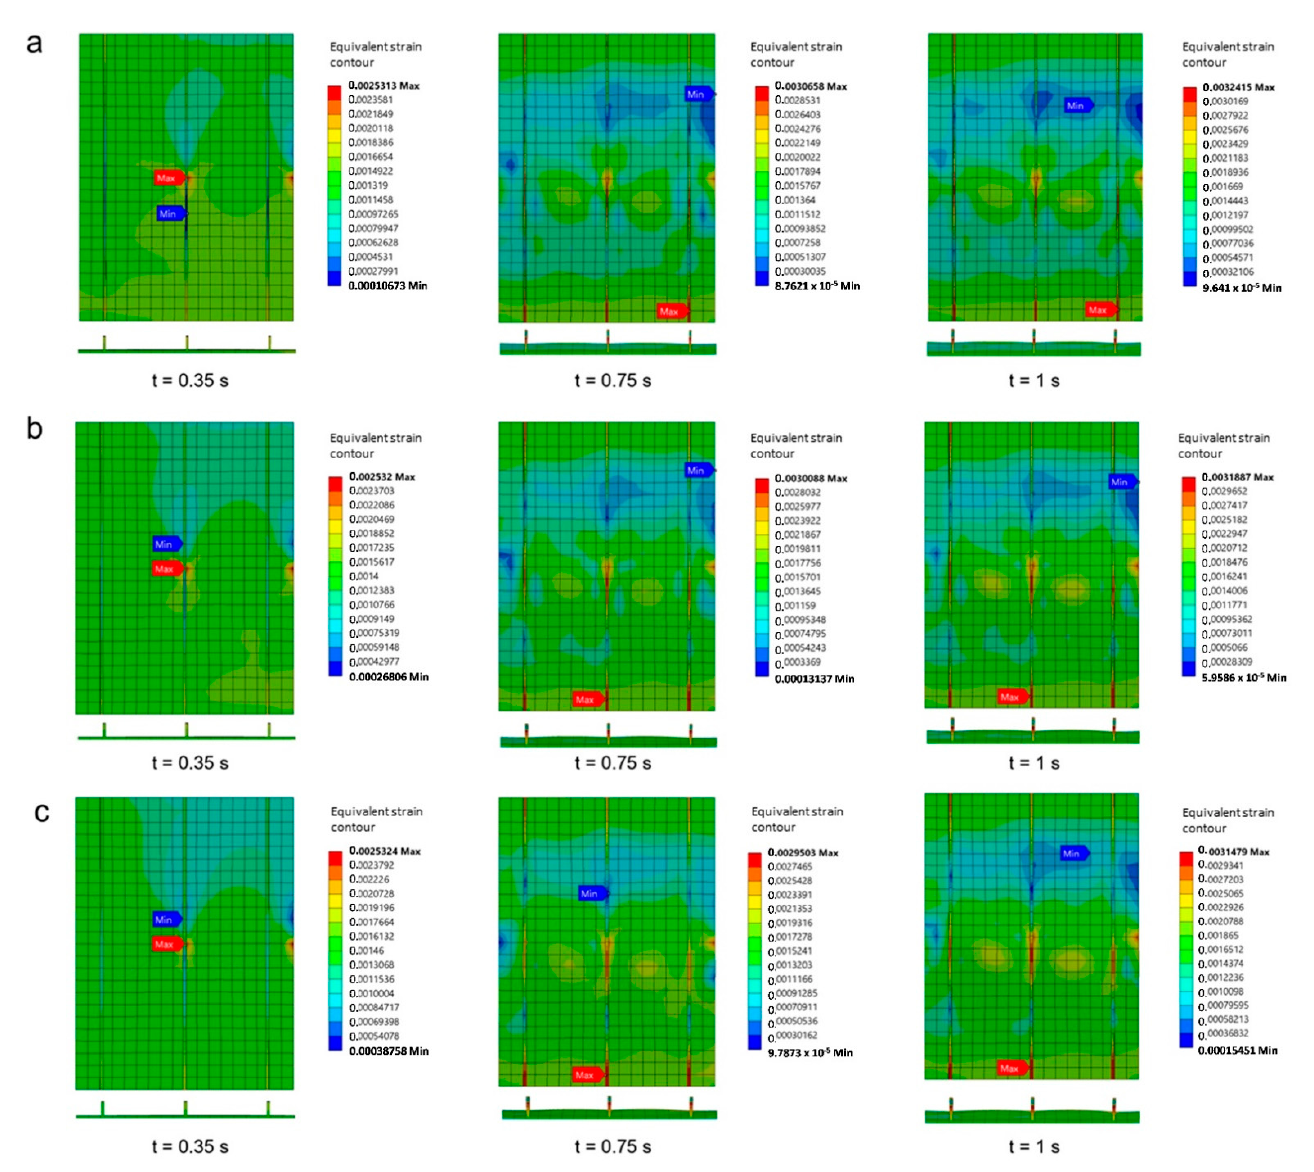
Figure 24. Equivalent strain contour in Specimen A: ( a ) 4 mm longitudinal stringers thickness; ( b ) 5 mm longitudinal stringers thickness; ( c ) 6 mm longitudinal stringers thickness.